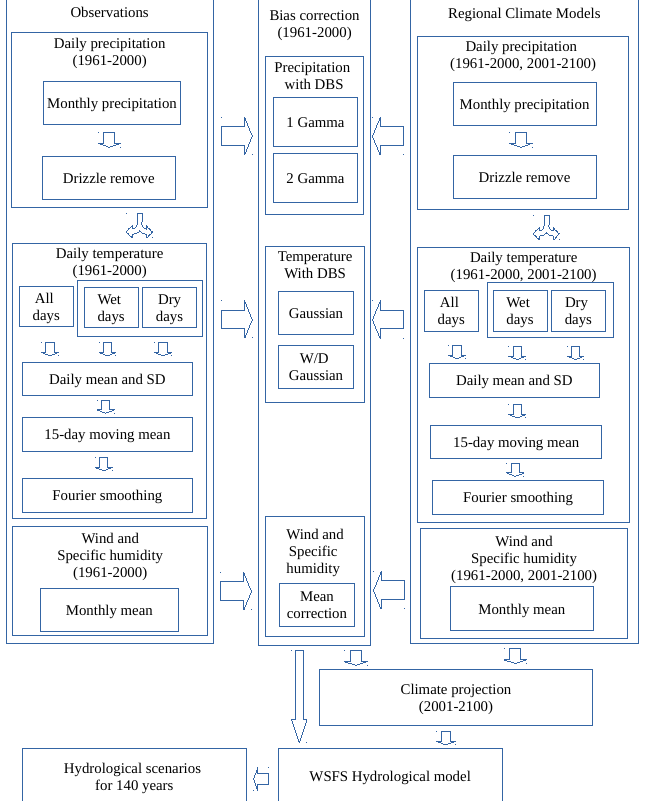
Figure 1. Schematic presentation of application procedure used in this study for hydrological modelling of climate change impact with bias corrected RCM